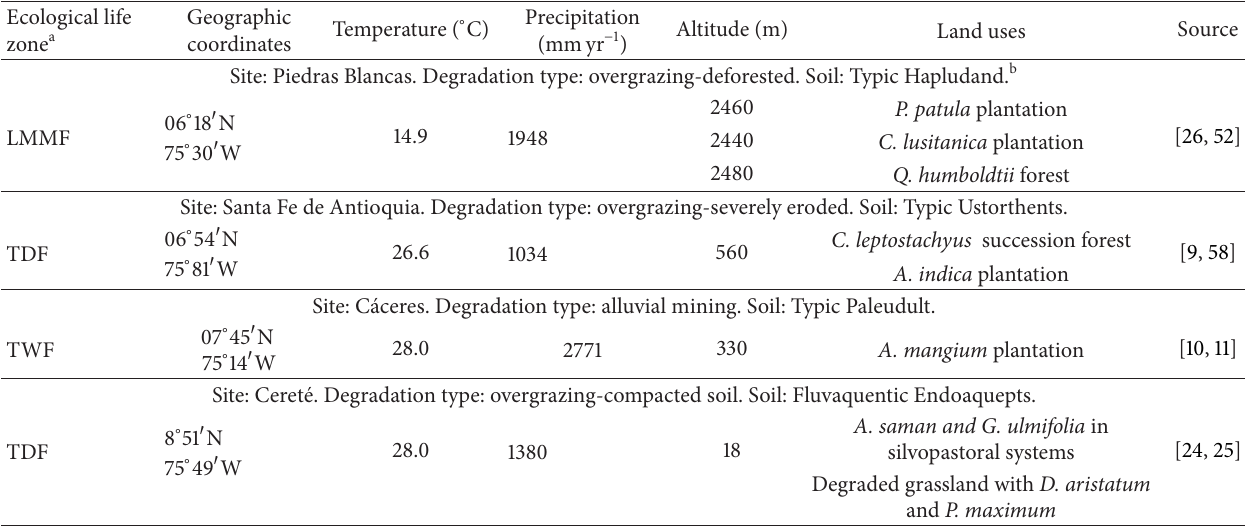
Table 1: General information on the experimental sites in